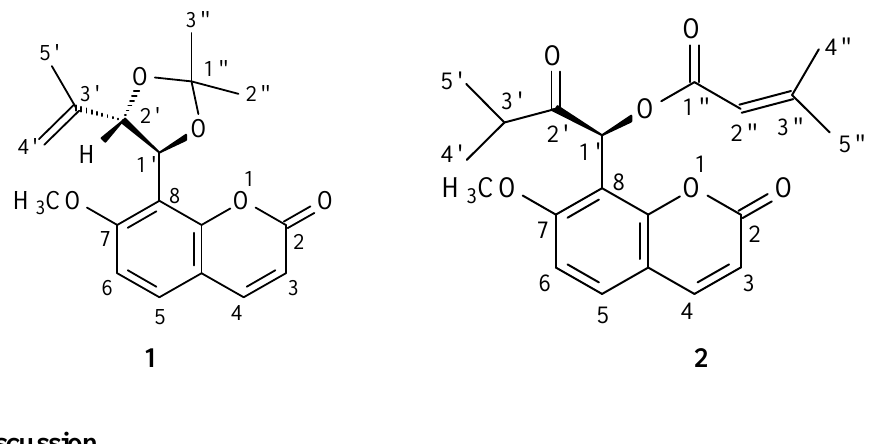
Figure 1. Structures of compounds 1 and 2